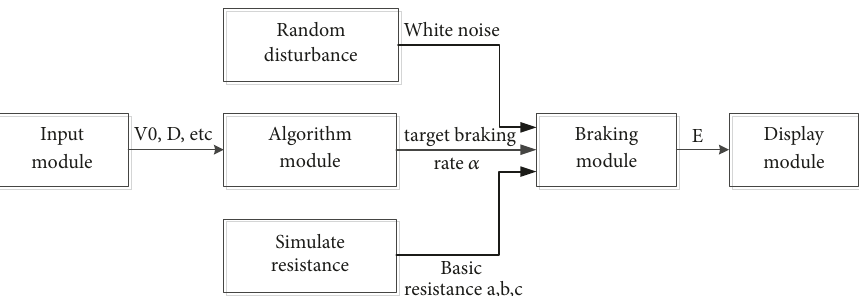
Figure 2: Structure of the parking simulation